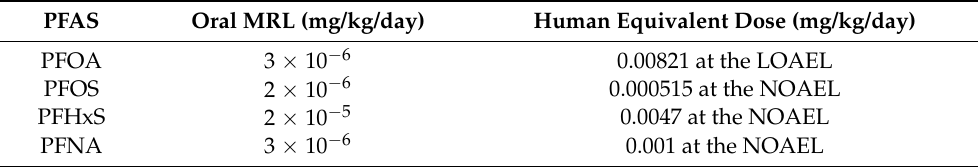
Table 3. ATSDR’s Oral Minimal Risk Levels (MRLs) and Human Equivalent Doses for Various PFAS. PFAS Oral MRL (mg/kg/day) Human Equivalent Dose (mg/kg/day) PFOA 3 × 10 − 6 0.00821 at the LOAEL PFOS 2 × 10 − 6 0.000515 at the NOAEL PFHxS 2 × 10 − 5 0.0047 at the NOAEL PFNA 3 × 10 − 6 0.001 at the NOAEL Adapted from ATSDR (2018)